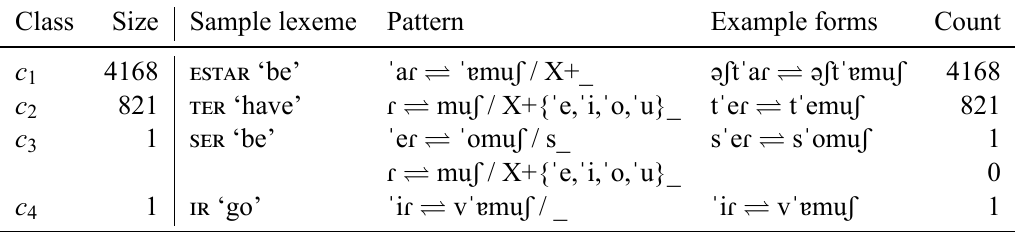
Table 11: Classes of INF for predicition of